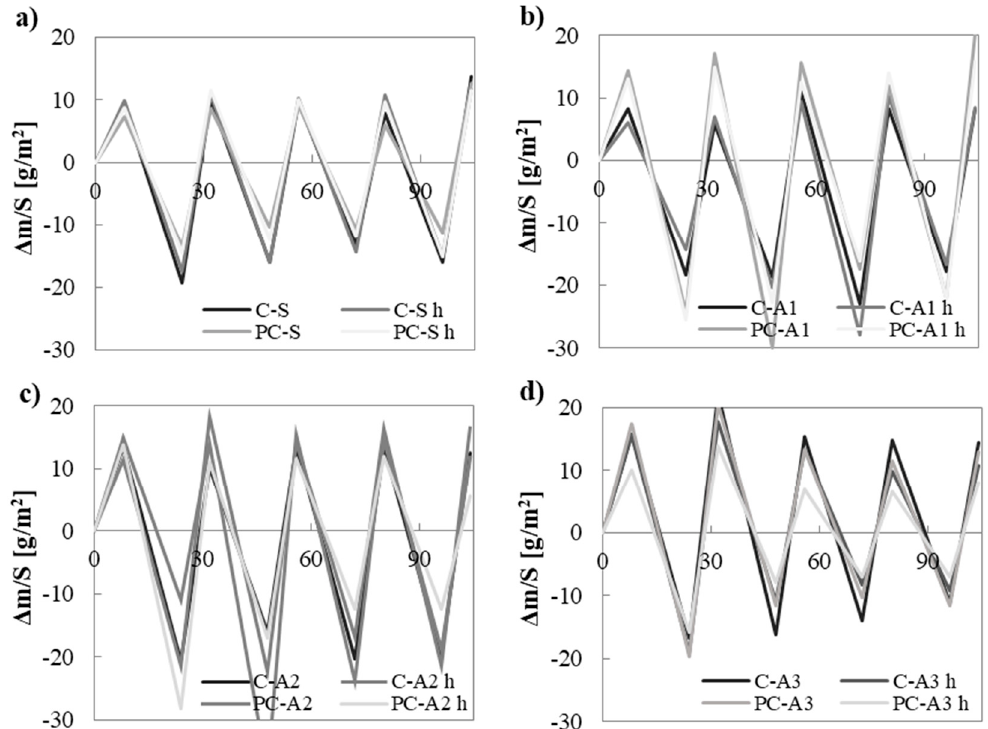
Figure 9. Change in water vapour content of mortars normalised on the surface of the specimens: ( a ) sand based mortars; ( b ) A1 based mortars; ( c ) A2 based mortars; ( d ) A3 based mortars. The use of different binders or hydrophobic admixture does not affect this behaviour. On the contrary, the